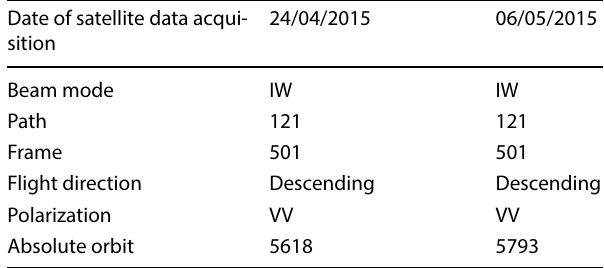
Table 2 Description of satellite images of Eastern